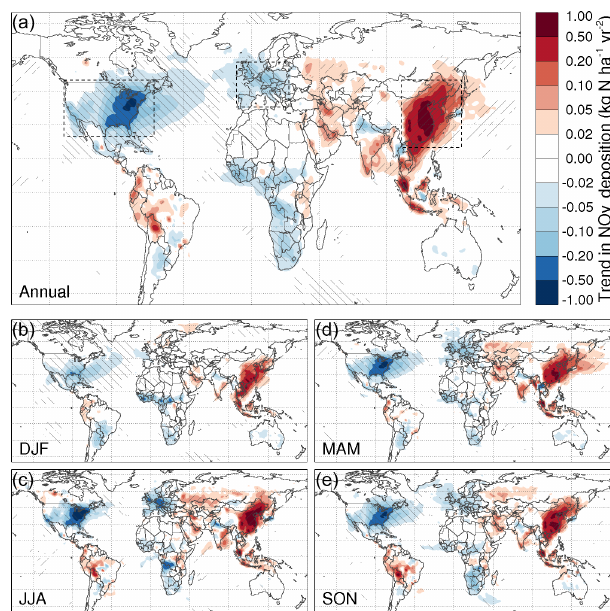
Figure 5. Long-term trend (1996–2014) in the satellite-constrained simulation of NO y deposition. (a) Annual mean; (b) December– (e) September–October–November. Diagonal hatching represents trend significance ( p <0.01). Hatching from top-left to bottom-right indicates a decreasing trend; hatching from bottom-left to top-right indicates an increasing